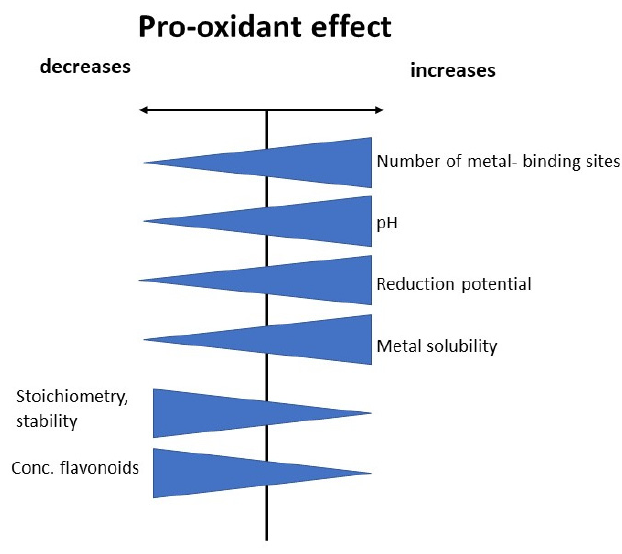
Figure 4. Summary of factors influencing pro-oxidant effect.